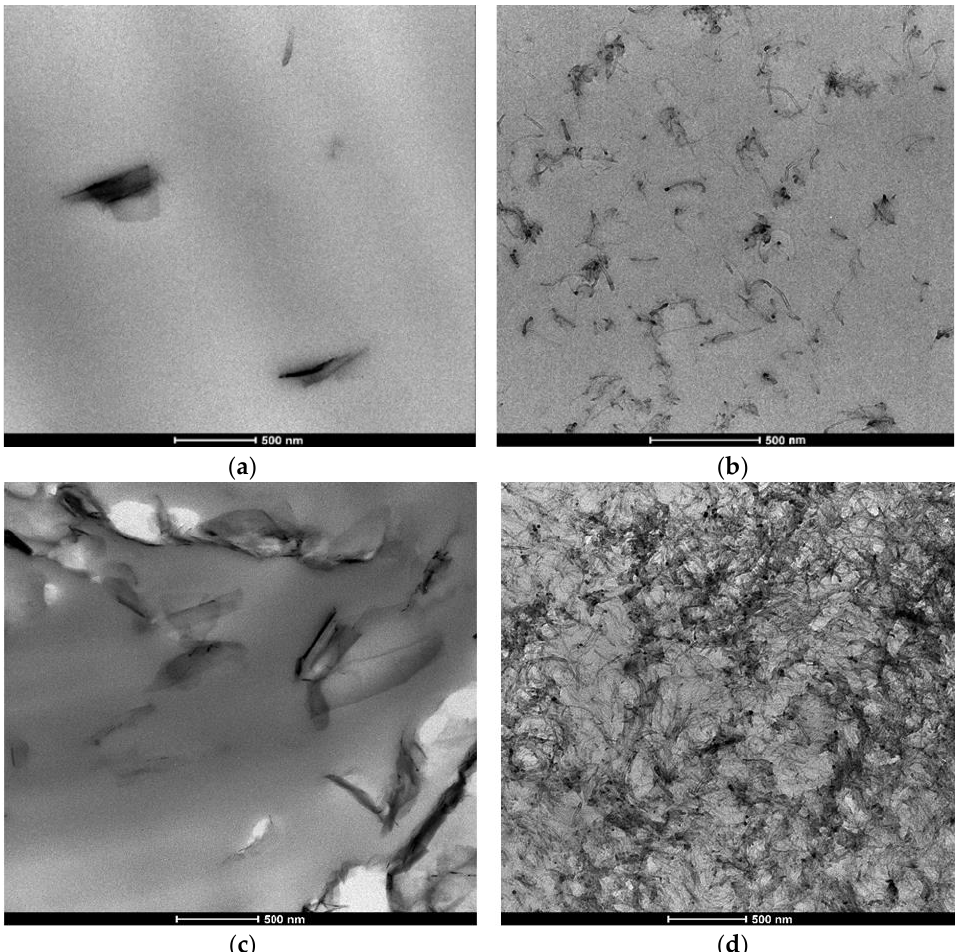
Figure 2. TEM micrographs of the hybrid nanocomposites: ( a ) 1.5 wt.% GNP/PLA, ( b ) 1.5 wt.% MWCNT/PLA; ( c ) 9 wt.% GNP/PLA, and ( d ) 9 wt.% MWCNT/PLA, at the same magnification.